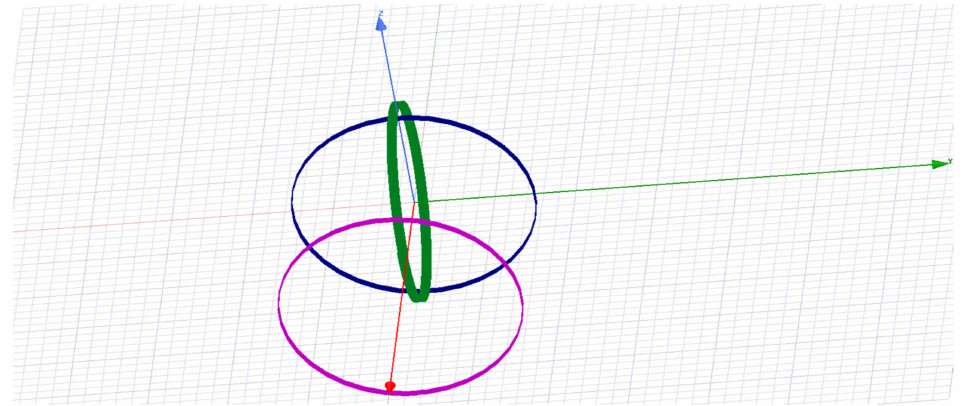
Figure 4. Two-dimensional (2D) WPT Ansys software simulation when the receiver rotates in the range of 0 ◦ to 360 ◦